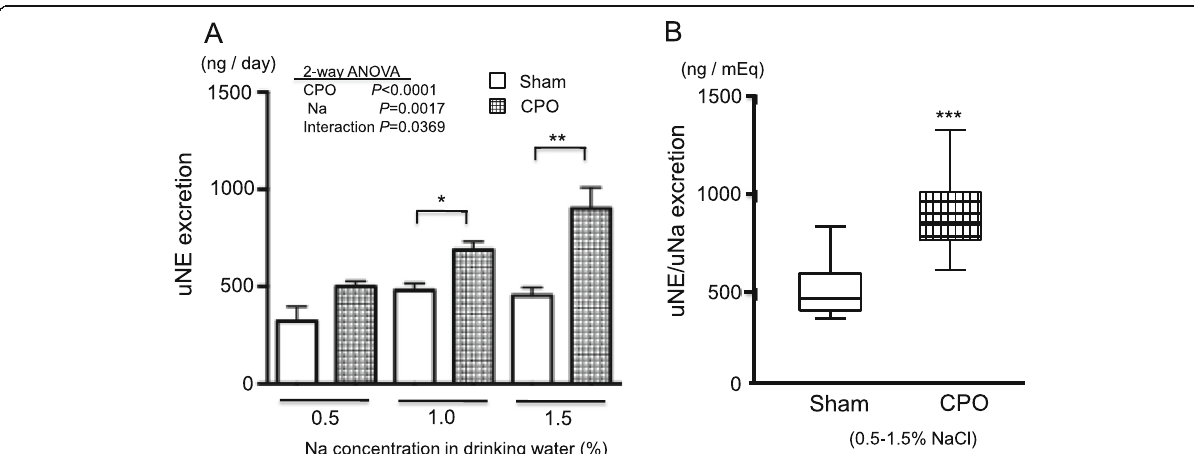
Fig. 1 a SNA evaluated on the basis of uNE excretion in each group. * p < 0.05, ** p < 0.01 Sham versus CPO, n = 8 for each. Open bar graphs indicate Sham; square-block bar graph indicates CPO. b The ratio of uNE/uNa excretion, as a marker of SNA in response to salt intake. *** p < 0.001 Sham versus CPO, n = 24 for each. Open bar graphs indicate Sham; square-block bar graph indicates CPO. SNA, sympathetic nerve activity; Sham, sham-operated control mice; CPO, chronic pressure overload mice; uNE, 24-h urinary norepinephrine; uNa, 24-h urinary